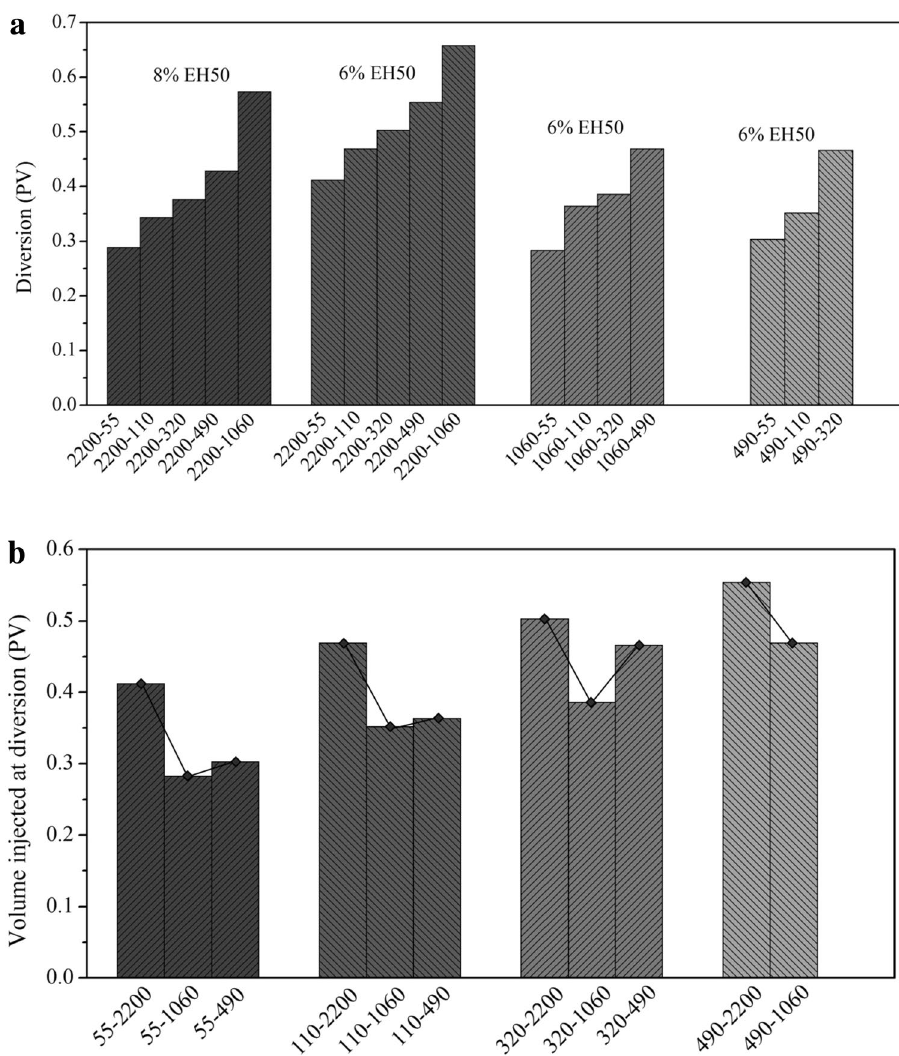
Fig. 6 a PV different diversion PV with different permeabil- ity. b Different diversion PV with different permeability